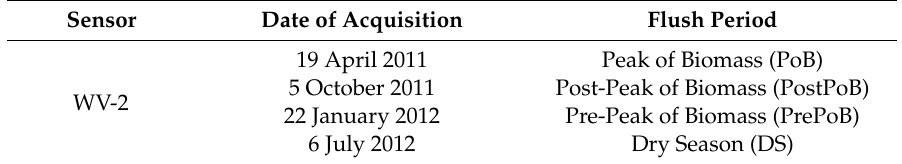
Table 1. List of the Earth Observation (EO) data used for Murgia Alta site. Information on the flush period is